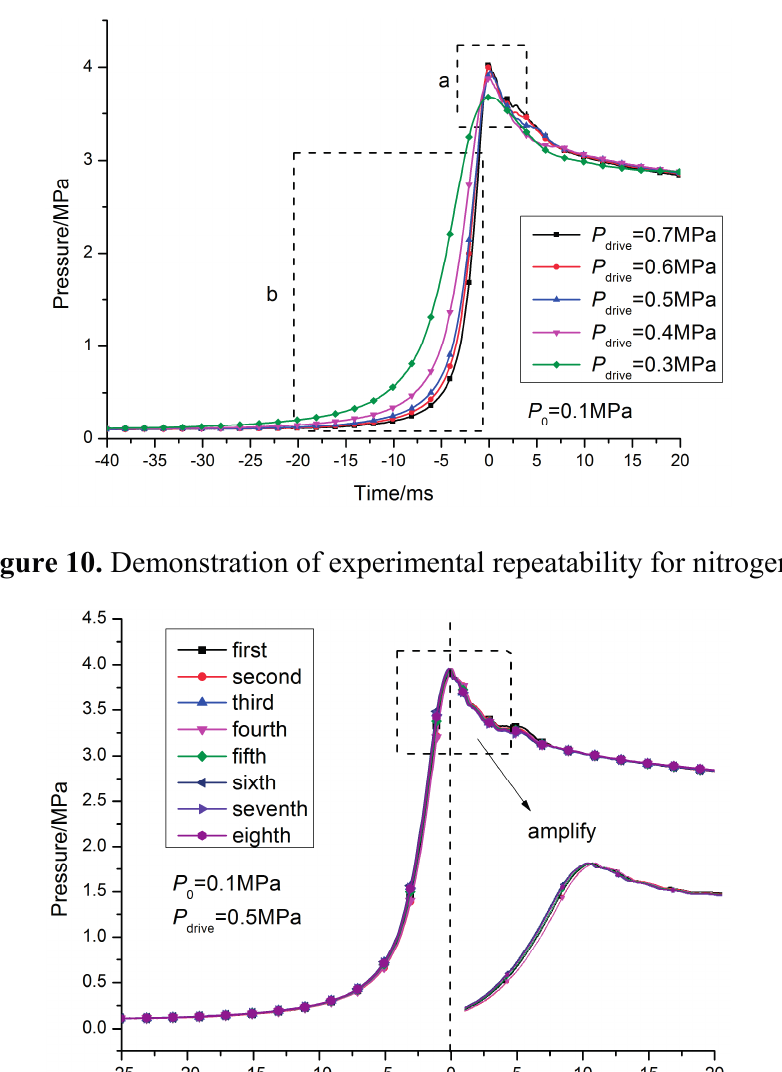
Figure 9. Effect of driving gas pressure on the compression pressure (after modification of the hydraulic buffer).